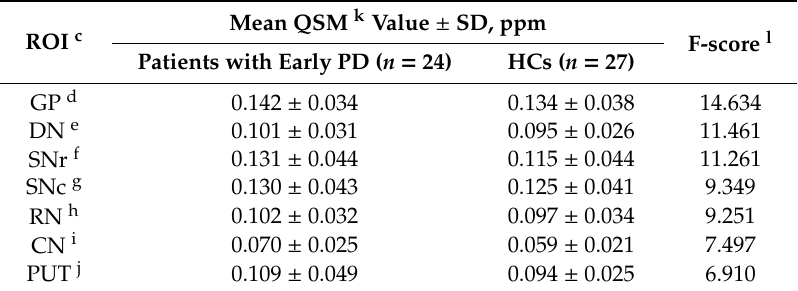
Table 2. QSM Values and F-scores for Patients with Early PD a and HCs b . Mean QSM k Value ± SD, ROI c